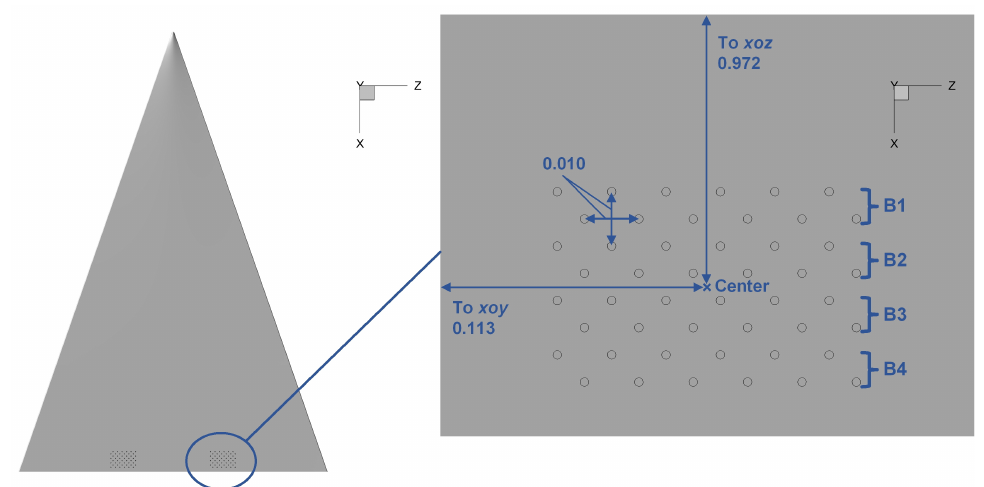
Figure 3. Position and Distribution of the